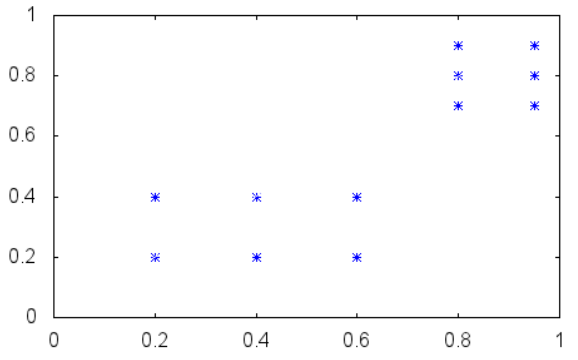
Figure 3. An even number n of points, n ≥ 4, following the distribution stated in Case (3) of Theorem